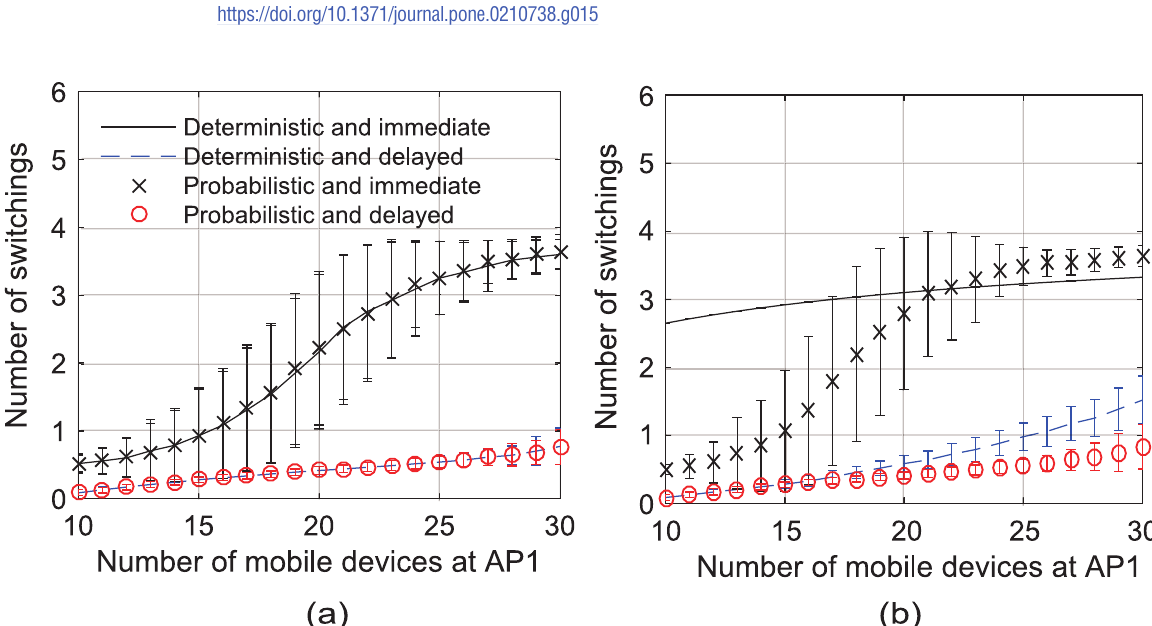
Fig 16. Average number of switchings per mobile device. (a) in the unsaturated learning situation and (b) in the saturated learning situation.